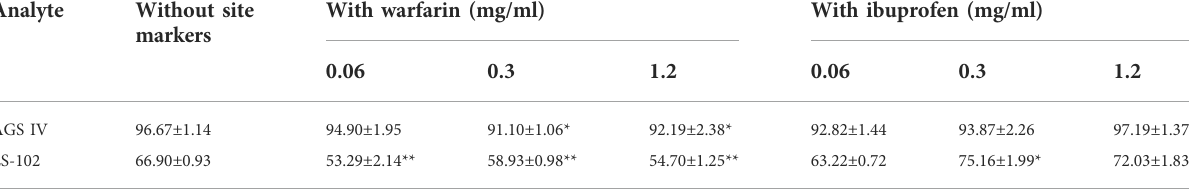
TABLE 2 Plasma protein binding of AGS IV and LS-102 plus site markers in HSA ( ‾ x ± s, n = 3). Analyte Without site